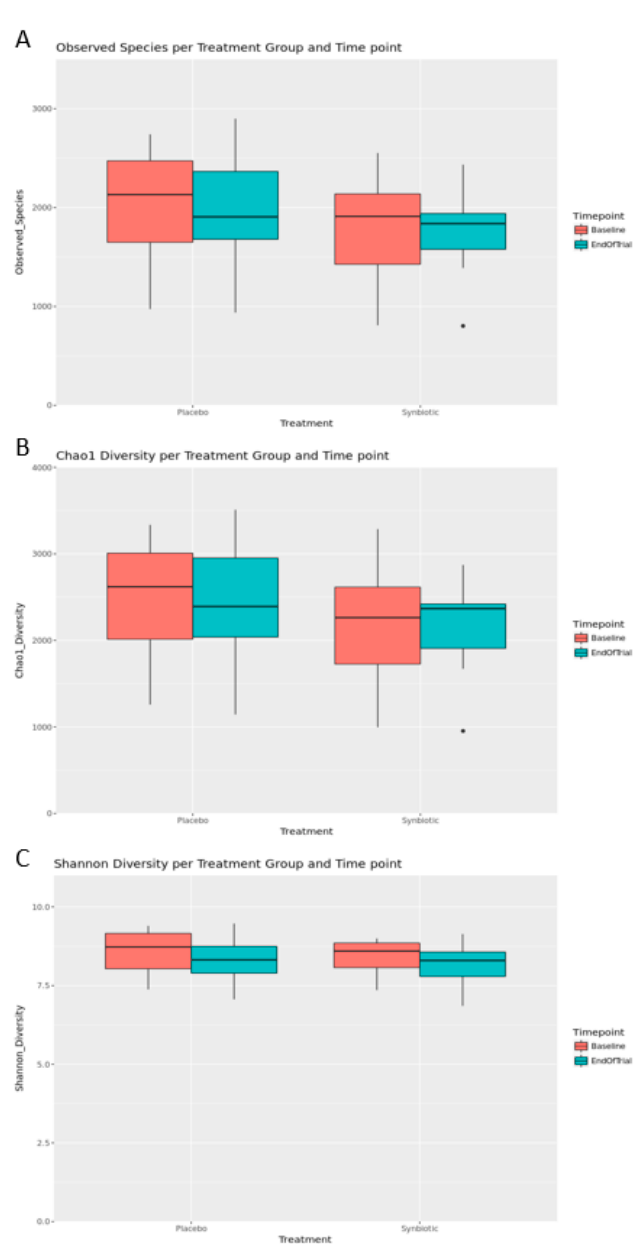
Figure 3. Observed species ( A ), Chao1 diversity ( B ) and Shannon diversity ( C ) plotted by the treatment group and time point. The box spans the first and third quartiles. A horizontal line marks the median and the whiskers represent ±1.5 times the interquartile range. Outliers (panels A and B ) are marked as individual points. Significant differences between groups were determined using the estimated marginal means analysis applied to linear mixed model, which was built with alpha diversity as the response variable, the treatment group and time points as predictor variables, and subject number as a random